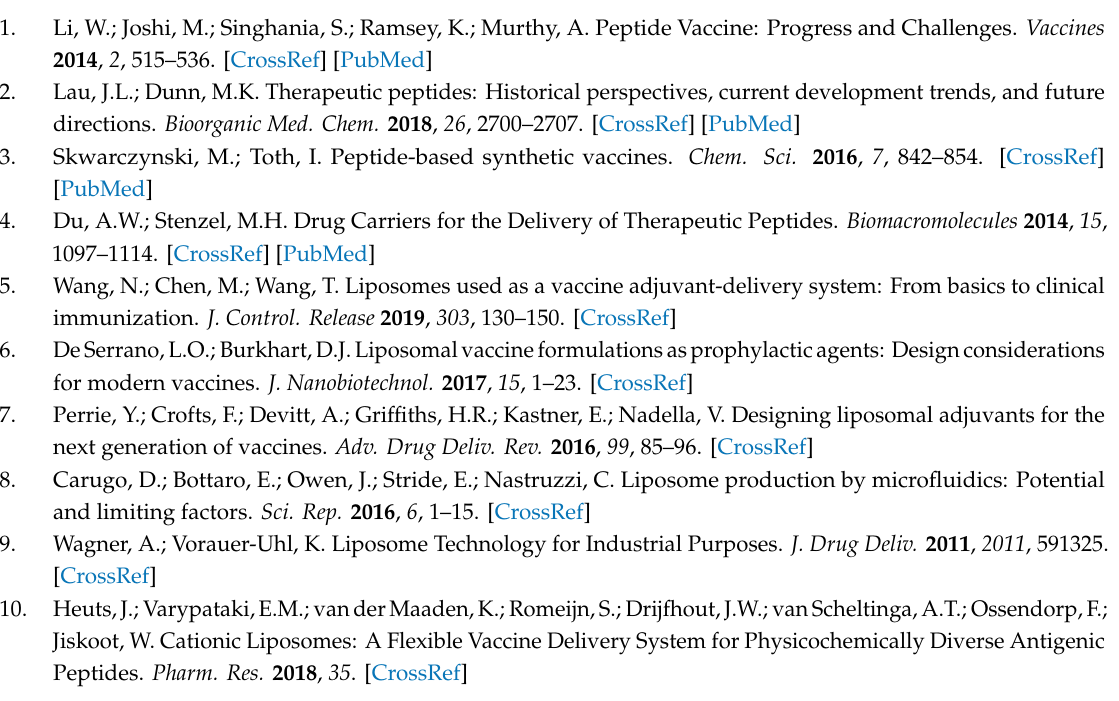
Figure S1: CD spectra of the model T helper cell peptide and its variants, Figure S2: Electrostatic interactions of OVA 323-339 3K with anionic liposomes, Figure S3: E ff ect of liposome composition and ionic strength on the encapsulation e ffi ciency of OVA 323-339, Figure S4: Encapsulation of the model T helper cell peptides into anionic liposomes (non-normalized / non-corrected), Figure S5: Stability of free and liposomal model T helper cell peptide under cell culture conditions, Figure S6: Gating strategy for the experiments shown in Figure 7, Figure S7: Antigen-specific CD4 + T-cell proliferation induced by various free (non-liposomal) OVA 323-339 variants, Figure S8: Antigen-specific CD4 + T-cell proliferation induced by liposomal OVA 323-339, Table S1: Calibration and validation of the peptide HPLC method, Table S2: Calibration and validation of the lipid HPLC method, Table S3: Zeta potential of liposomes upon the addition of peptides (control experiments), Table S4: Z-Average particle size and PdI of liposomes upon the addition of peptides (control experiments), Table S5: Binding of the model T helper cell peptide and its variants to liposomes (control experiments), Table S6: Physico-chemical characterization of peptide-loaded liposomes prepared by thin-film hydration, Table S7: Physico-chemical characterization of peptide-loaded liposomes prepared by microfluidic mixing, Table S8: Physico-chemical characterization of peptide-loaded anionic liposomes used in the in vitro co-cultivation, Table S9: Lipid recovery, peptide content and encapsulation e ffi ciency of anionic liposomes used in the in vitro